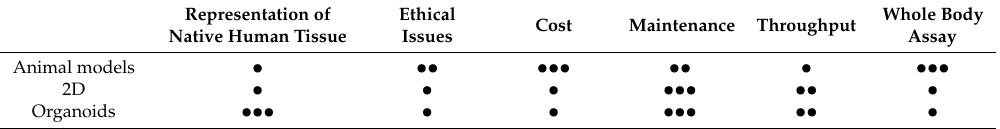
Table 1. Comparison between animal models and in vitro 2D and organoid cultures derived from human induced pluripotent stem cells (hiPSCs) as tissue models for drug discovery. Legend: • low,